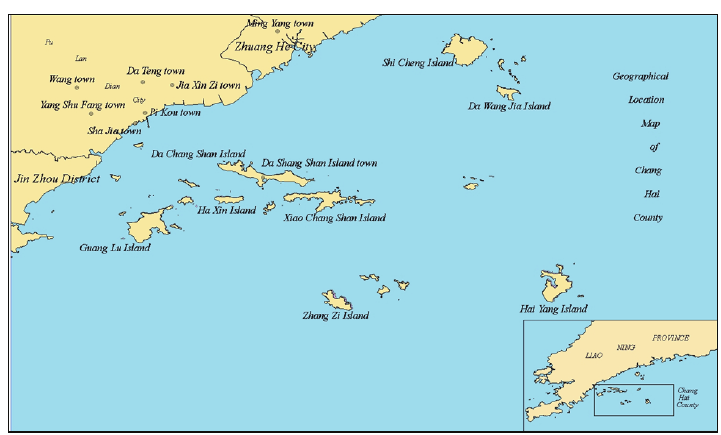
Figure 3: Geographical location map of Changhai County of